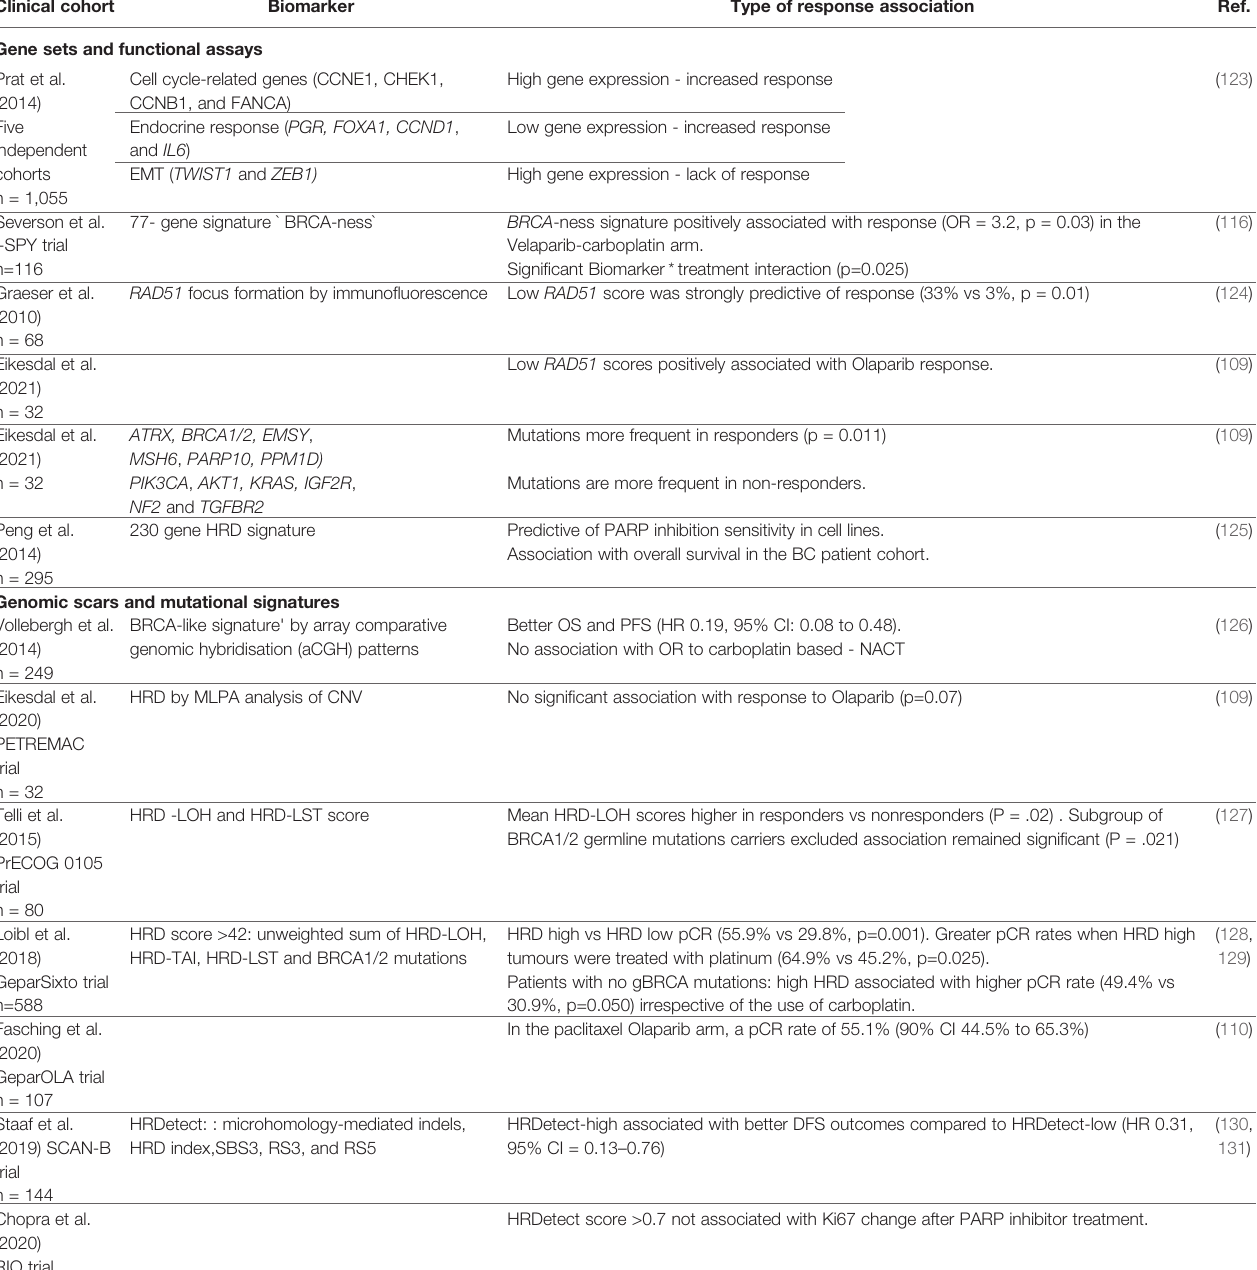
TABLE 7 | HRD related biomarkers and its association with treatment